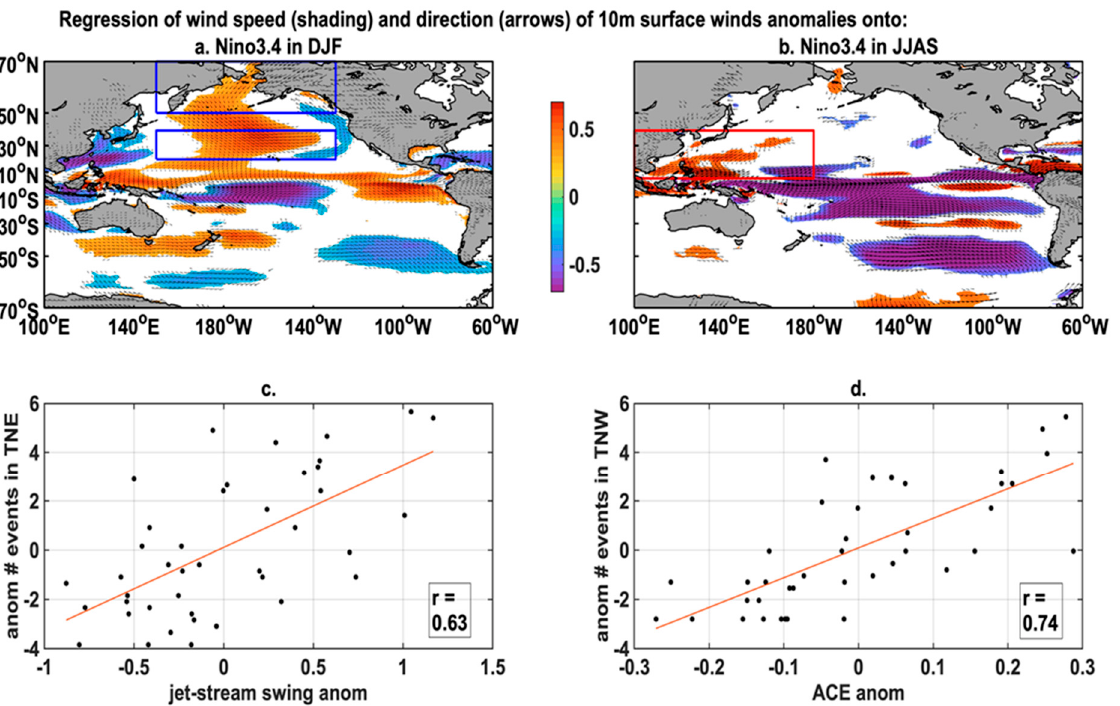
Figure 6. Regression of wind speed (shading) and direction (arrows) of 10 meters surface winds anomalies onto the Niño3.4 index averaged in December–February ( a ) in June–September ( b ). Only regressions significant at the 95% level according to a Student t -test are displayed. Relationships ( c ) between the interannual anomalies of extreme open-ocean wave occurrence in the Pacific Tropical North-East in December–February and an index characterizing the ENSO-induced meridional swing of the Northern-Hemisphere jet stream and ( d ) between the interannual anomalies of extreme open-ocean wave occurrence in the Pacific Tropical North-West in June–September and an index characterizing the anomalous tropical cyclone activity in the region delineated by the red box on panel b (Accumulated Cyclone Energy anomalies, “ACE